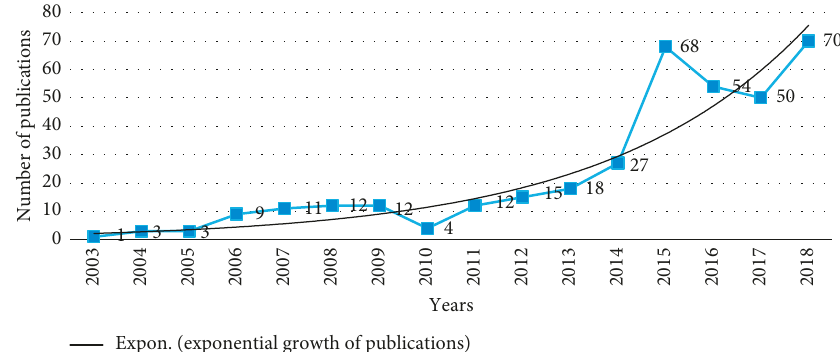
Figure 2: Variations in the number of BIM publications in the area of structural